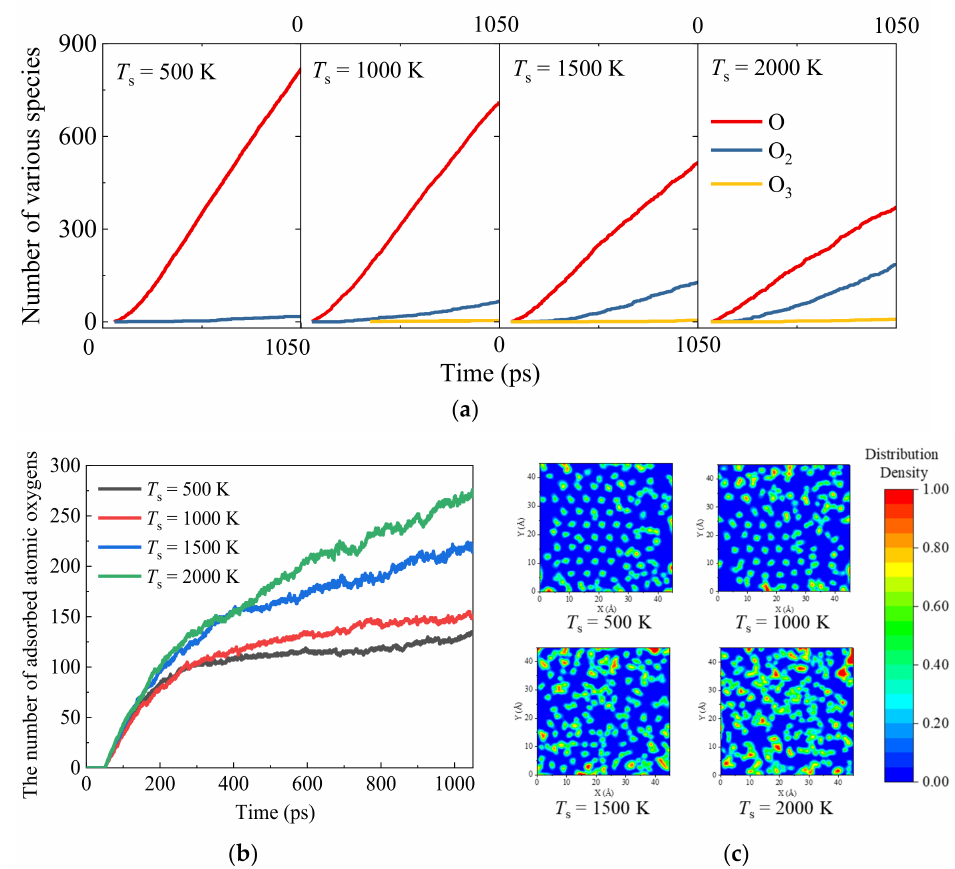
Figure 3. Surface adsorption of oxygen atoms for Models 1–4. ( a ) The number of various species in the gaseous phase, ( b ) the number of oxygen atoms adsorbed with variations of time, and ( c ) the effects of silica surface temperature on the saturated oxygen-atom density